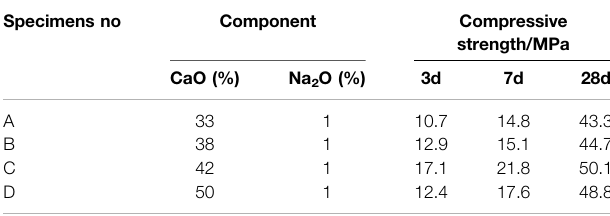
TABLE 2 | Compressive strengths of the